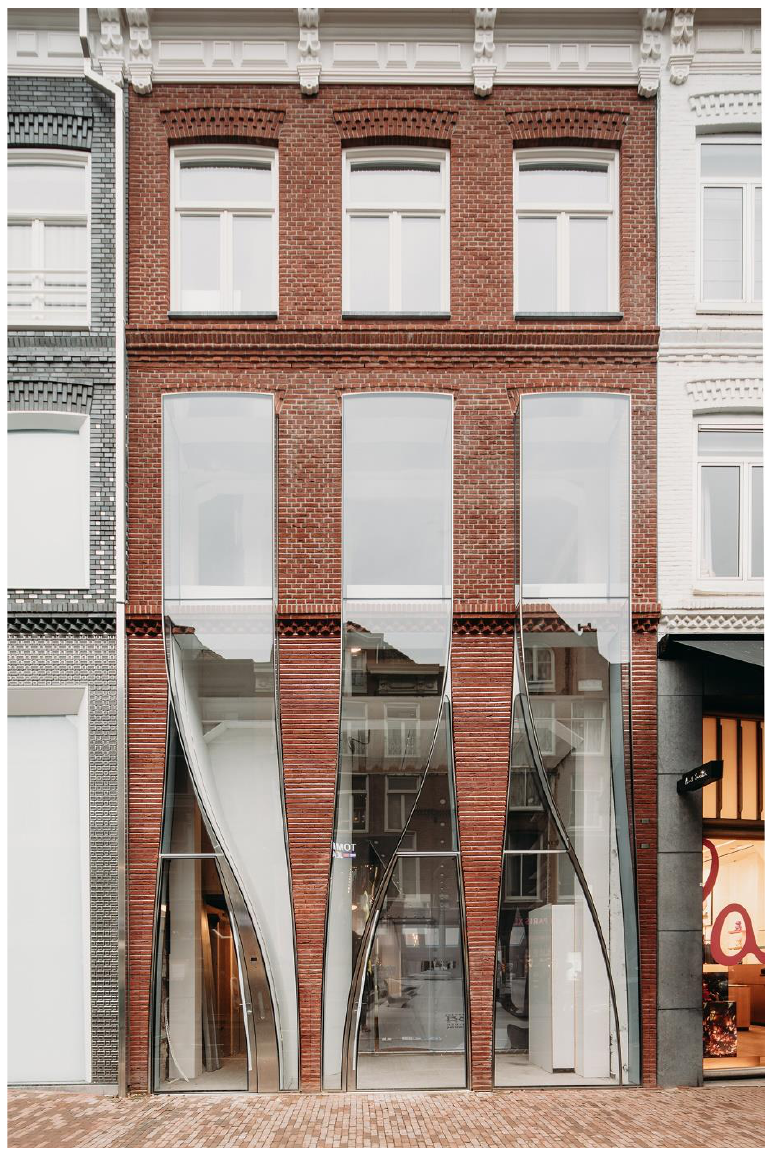
Fig. 3 P.C. Hooftstraat 138 ©